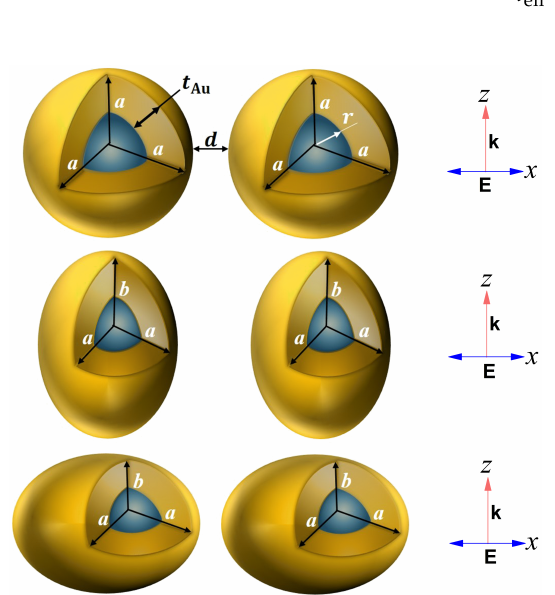
Figure 1. Schematic diagrams of the spherical and non-spherical core-shell nanostructures (top row: spherical, middle: prolate, bottom: oblate). a and b are the semi-principal axes of the nanostructures, d is the distance of separation between the outer surfaces of the nanostructures, t Au is the Au shell thickness, and r is the core radius for the spherical Au nanoshell (AuNS). k is the incident plane wave along the z -axis, and E is the electric field polarization along the x